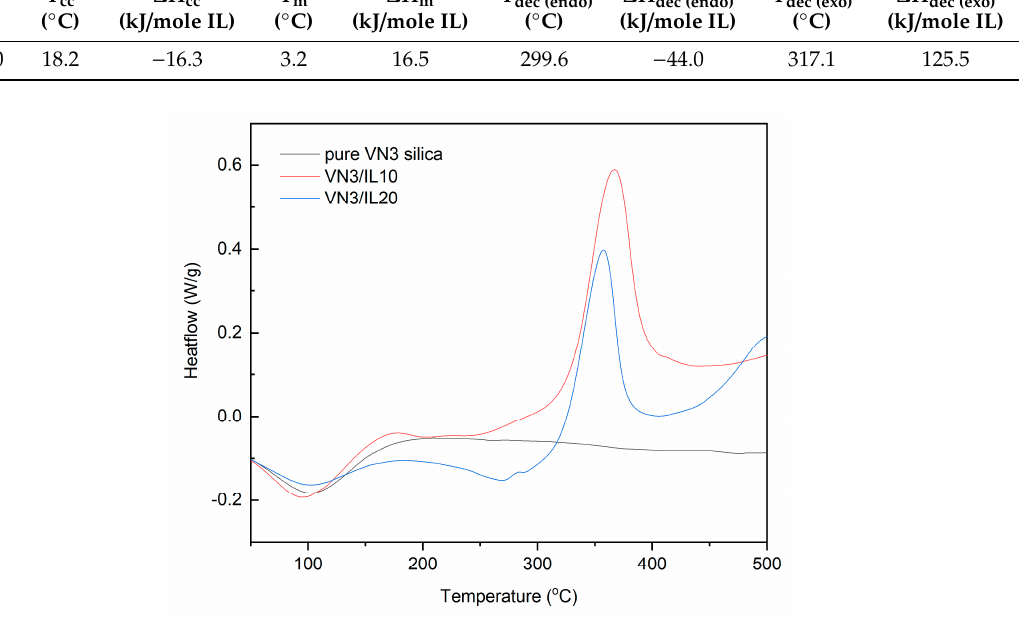
Figure 7. DSC curves for pure and DmiBr-modified VN3 silica (exo^).